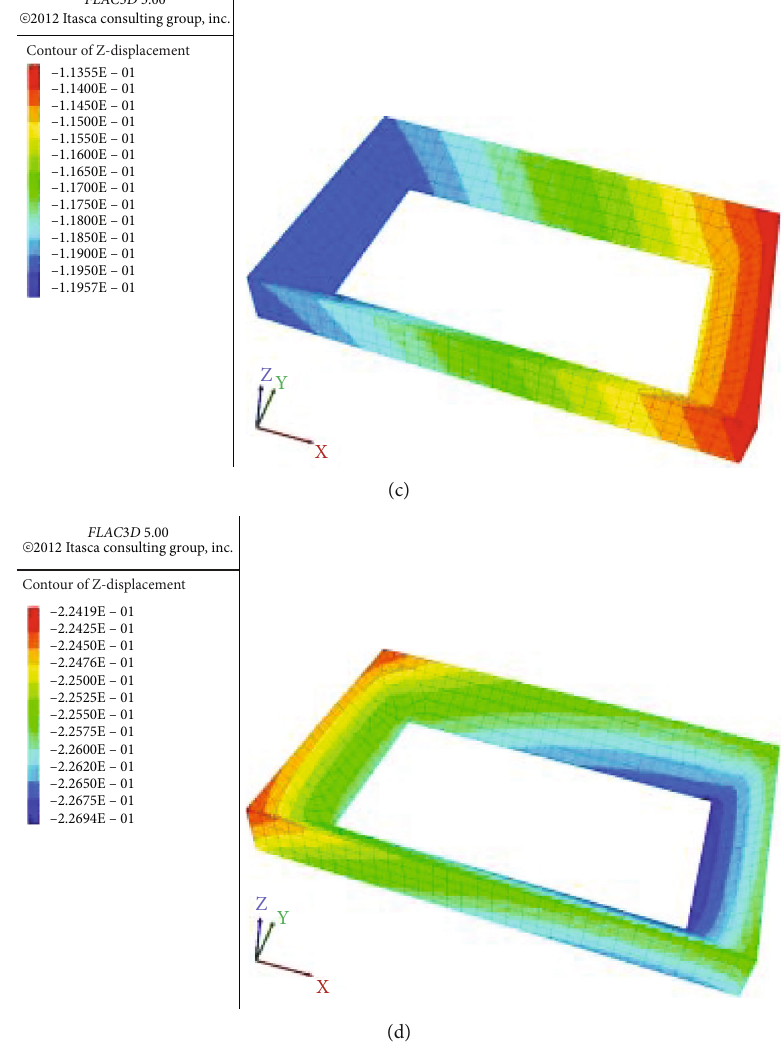
Figure 6: Displacement cloud diagram of unreinforced boat pond at di ff erent advancement distances: (a) advance 250m; (b) advance 500m; (c) advance 750 m; (d) advance